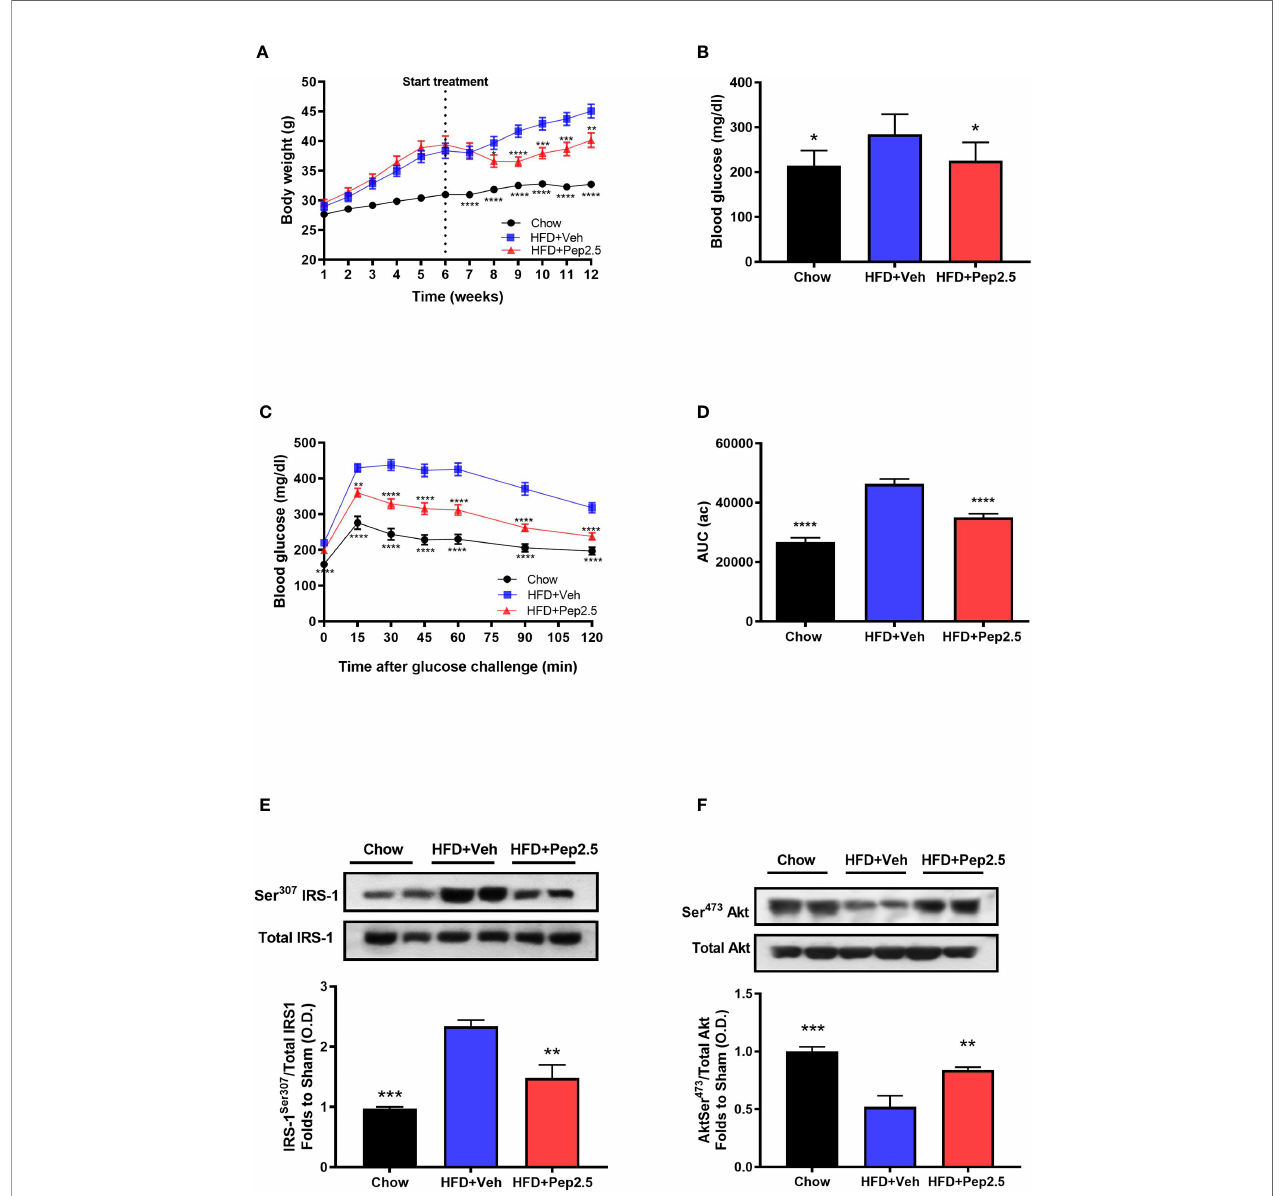
FIGURE 2 | Peptide 19-2.5 ameliorated glycemic regulations by the improvement of insulin signaling in HFD-fed mice. (A) Body weight was measured once a week for 12 weeks (g). (B) Non-fasting glucose levels were measured at week 12 (mg/dl) (C) Oral glucose tolerance (OGTT) was assessed over 120 min, after receiving an oral dose of glucose at week 12 (mg/dl) and the (D) area under the curve (AUC) of OGTT was calculated for respective groups and used for statistical analysis (au). Data are expressed as mean ± SEM; n = 20 per group, n = 10 for non-fasting glucose levels. *P < 0.05, **P < 0.01, ***P < 0.001, and ****P < 0.0001 vs. HFD + Veh. (E) Densitometric analysis of the bands is expressed as relative optical density (O.D.) for the phosphorylation on Ser 307 IRS-1in the liver and normalized to total IRS-1 and (F) for the phosphorylation on Ser 473 of Akt in the liver normalized to total Akt. Data was analyzed by one-way ANOVA, with Bonferroni post-hoc test. Data are expressed as mean ± SEM; chow (n = 5), HFD+Veh (n = 6), HFD+Pep2.5 (n = 6). **P < 0.01 and ***P < 0.001 vs.